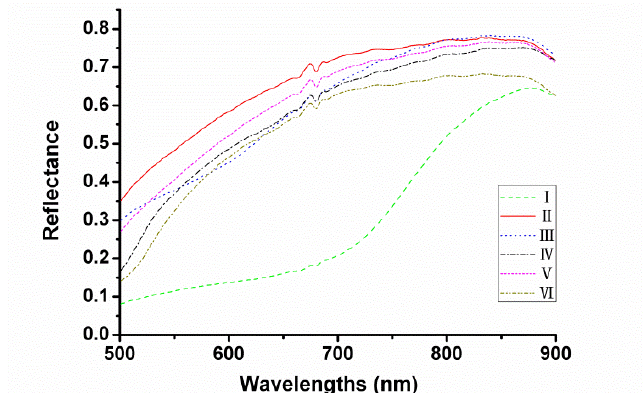
Figure 3. Vis/NIR reflectance of six different maize seeds extracted from the ROI pixels of hyperspectral images.